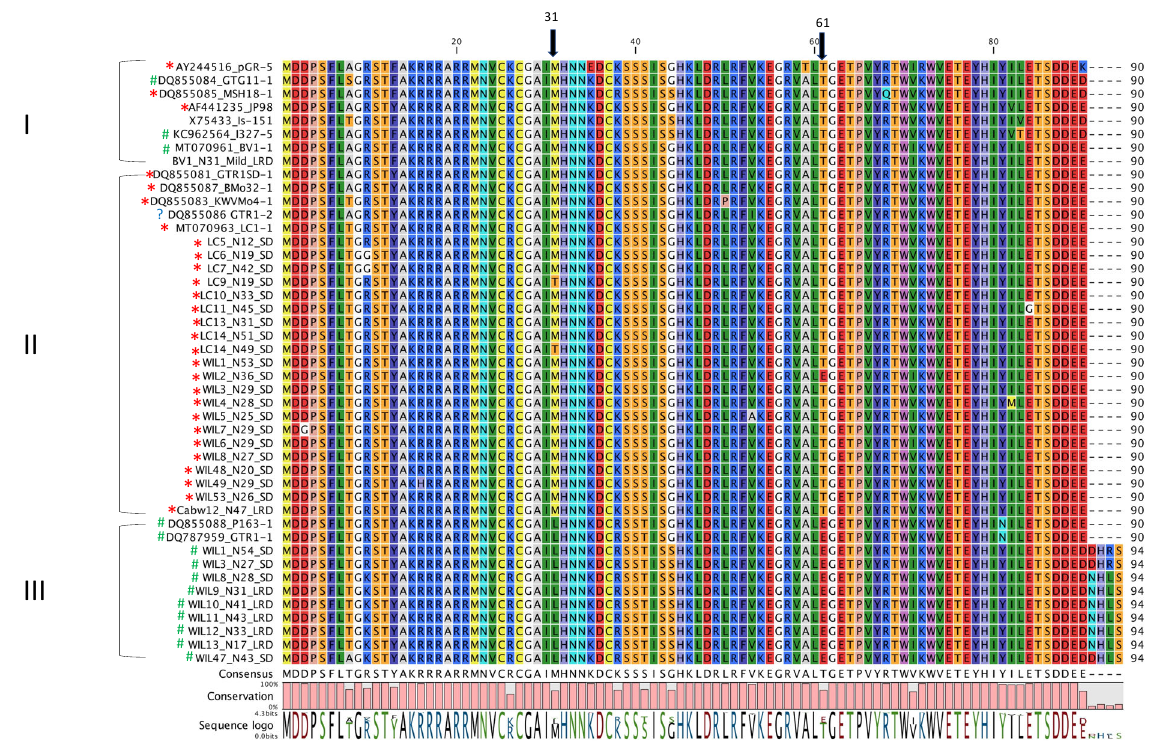
Figure 3. Amino acid alignment of the N-terminal (90–94 aa) of the RNA-binding gene of grapevine virus A (GVA) of Australian and international isolates. The phylogenetic group (I, II or III) of each isolate is on the left. Red * indicates isolates associated with Shiraz disease (SD) and green # indicates isolates not associated with SD. The blue question mark indicates a SD ‐ negative isolate in phylogenetic group II [11]. The two black arrows point to positions 31 and 61 of the alignment.